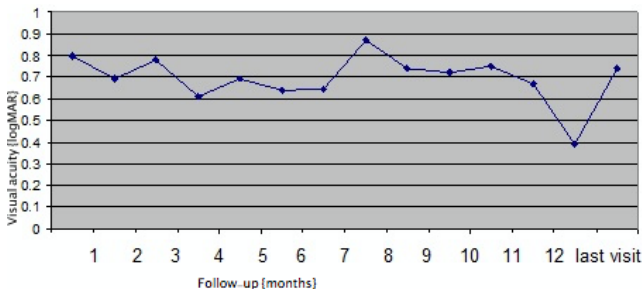
Figure 4: Monthly changes in logMAR visual acuity after Ozurdex ® injection for refractory diabetic macular edema in 28